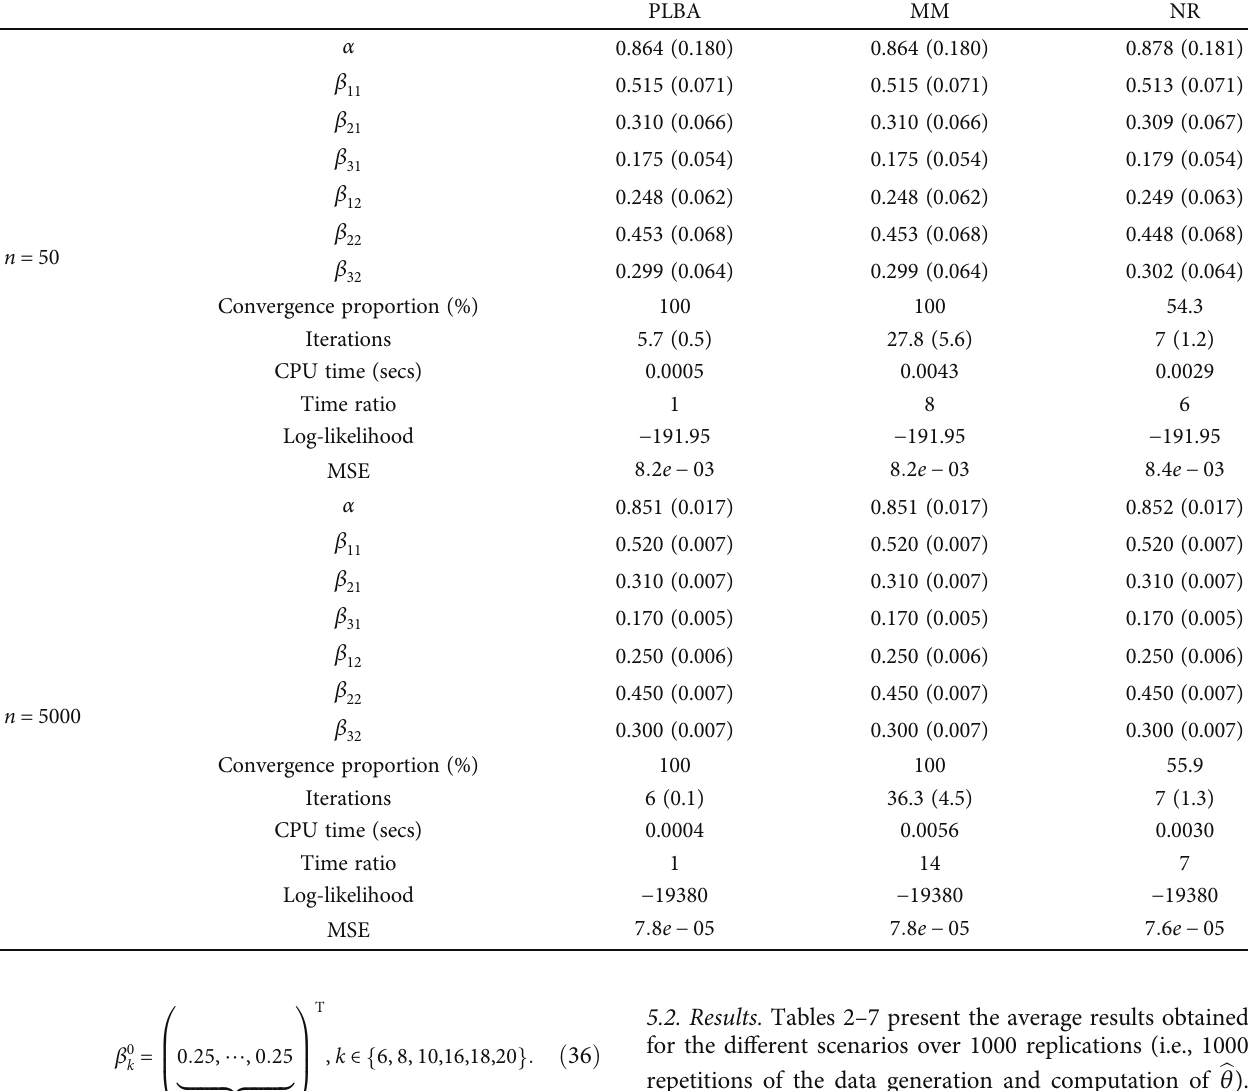
Table 2: Results for Scenario 1 (values in brackets are standard